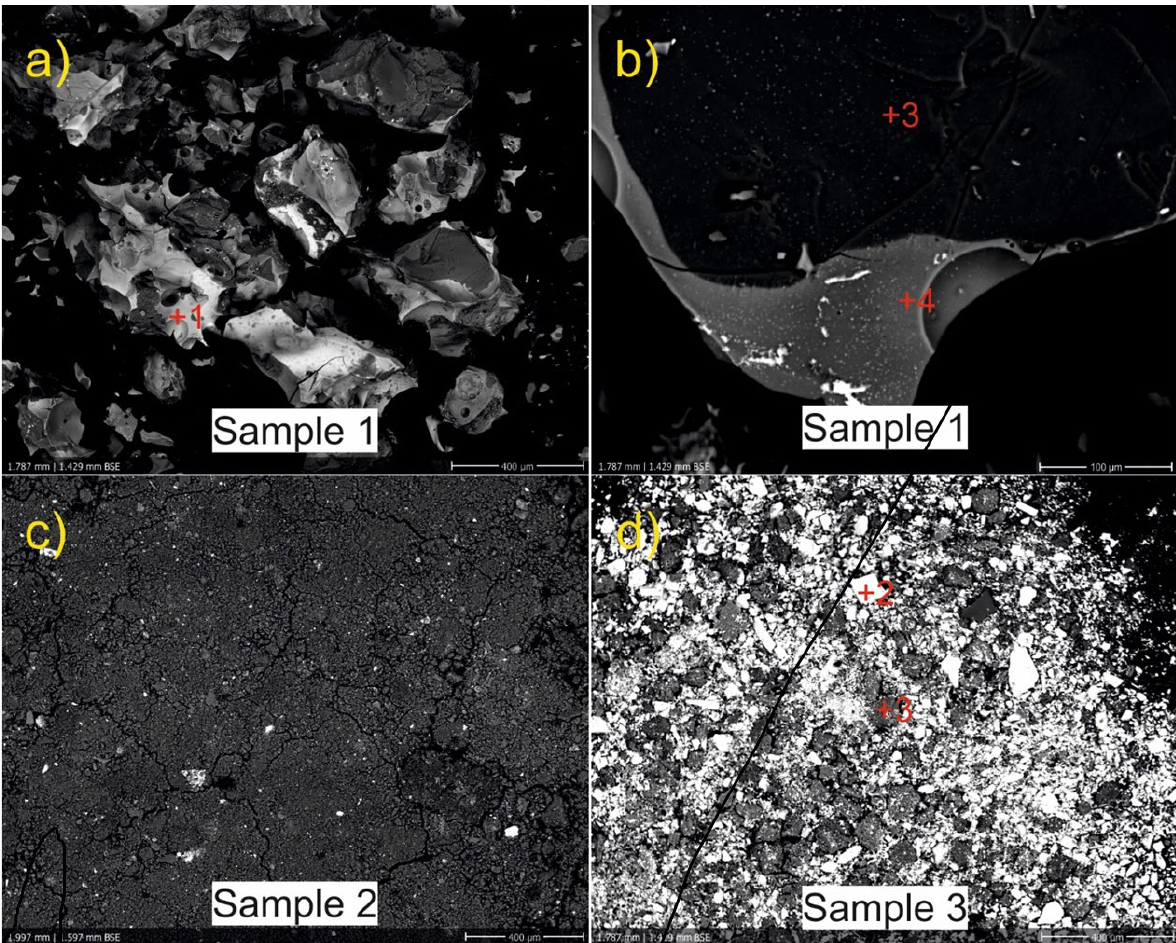
Figure 2. BSE images of the powders encountered in Vodní ulice Street. Crushed glass or frit ( a , b ) composed of glass of variable chemistry, pink powder ( c ), and blue powder ( d ). The numbers in red indicate the points of SEM-EDX analysis and correspond to the numbers of analyses in Table 1. Table 1. EDX results of the three samples in wt%.